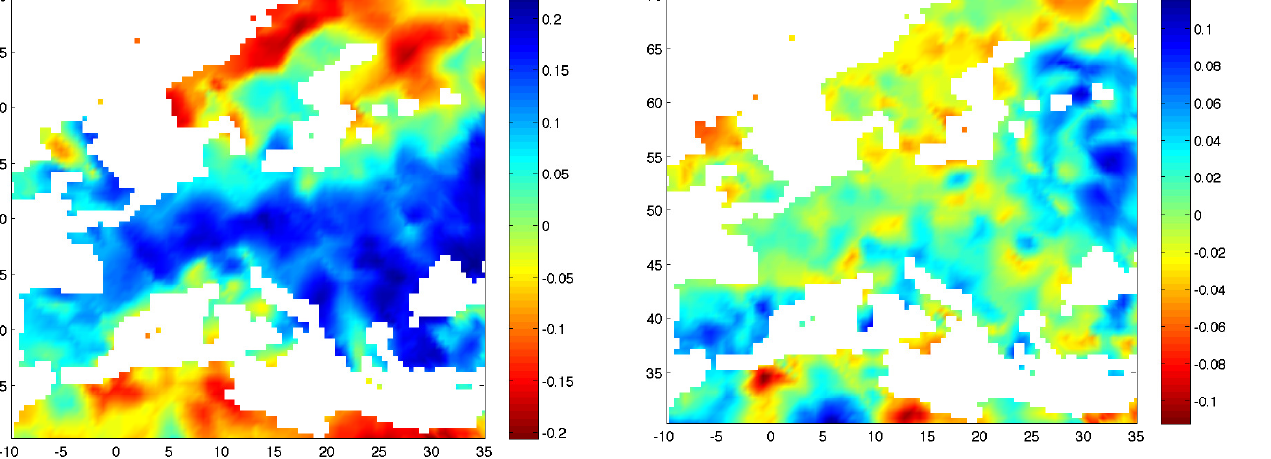
Fig. 2. Correlation between the cold season (DJF) Nino3 index (Mann et al., 2000) and the seasonal (DJF) precipitation reconstruc- tion over Europe (Pauling et al., 2006; Mitchell and Jones, 2005). Red indicates negative correlations corresponding to drier condi- tions and blue positive correlations associated with wetter condi- tions. While correlations may be weak the spatial structure is nev- ertheless non-random.